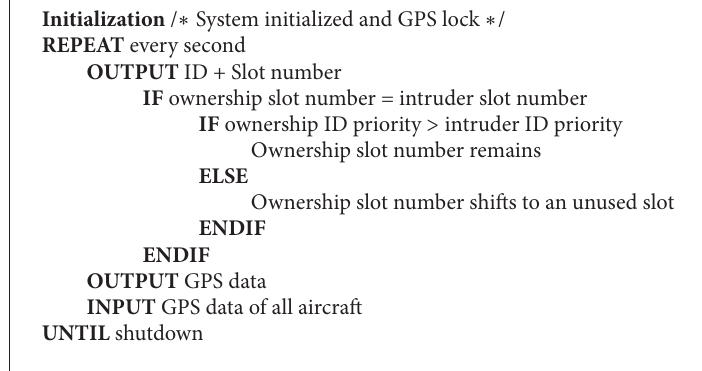
Algorithm 1: Transceiver architecture.